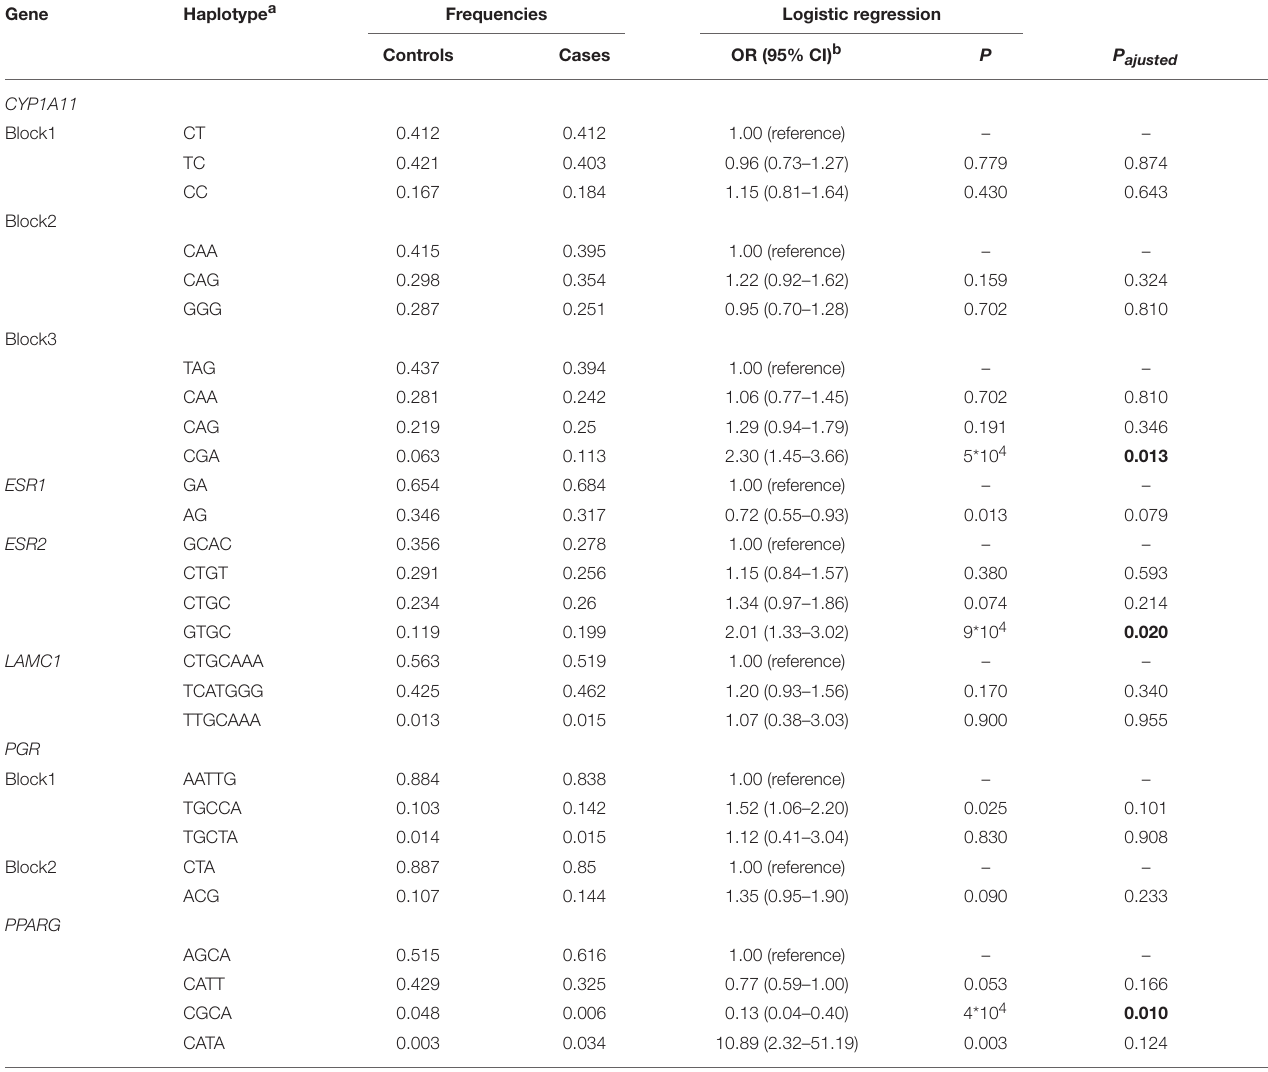
TABLE 5 | Association between CYP11A1, ESR1, ESR2, LAMC, PGR, and PPARG genetic haplotypes and PCOS risk. Gene Haplotype a Frequencies Logistic regression Controls